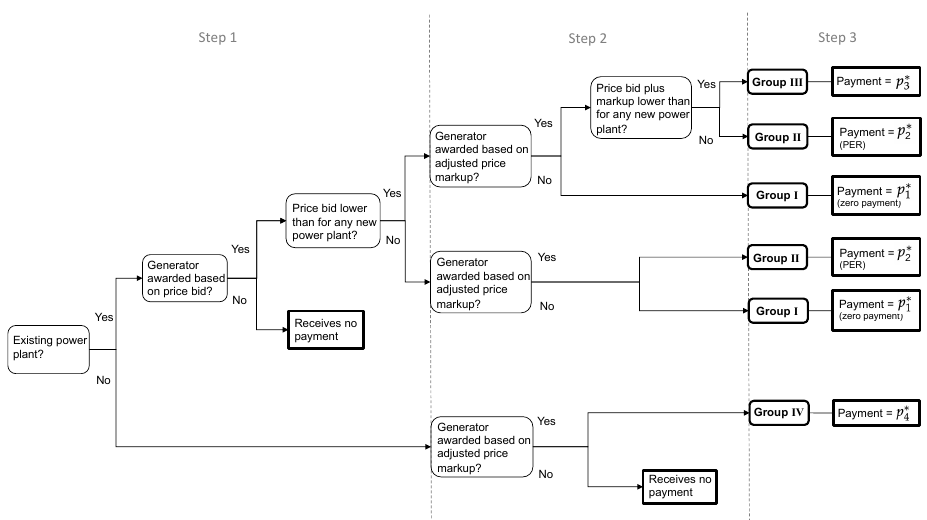
Figure 6. Decision tree of the awarding process. All awarded bidders are included in one of the four groups. Bidders of group I receive no payment but still have to pay the PER due to ROs. In contrast, non-awarded bidders do not have to pay the PER, while they also do not receive any payment. However, they have to leave the market if they are not awarded